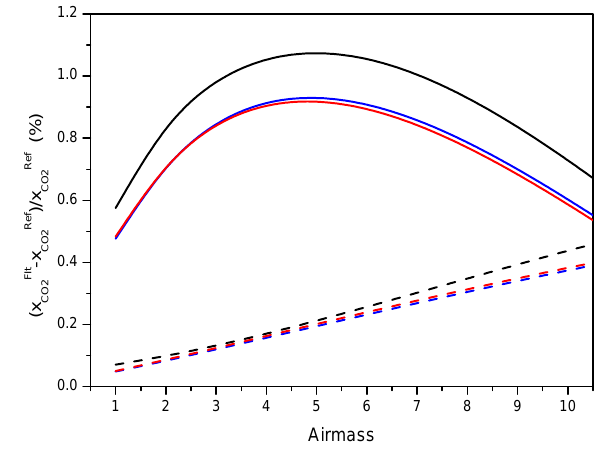
Fig. 2. Relative errors, induced by neglecting LM, in the CO 2 vmrs deduced from fits of spectra with a 50cm MOPD for various airmasses. The CO 2 vmr and a linear 100% transmission have been adjusted. Full line and dashed line are values obtained in Band#1 (4765–4915cm − 1 ) and Band#2 (6160–6270cm − 1 ), respectively.